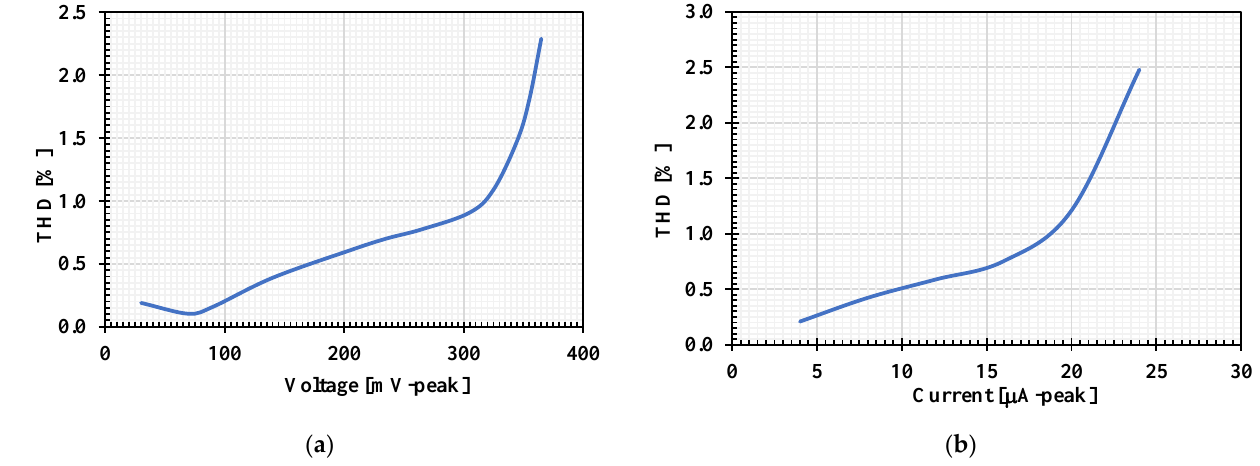
Figure 12. The simulated THD of the LP filters with different amplitude of input signal at 100 Hz: ( a ) VM filter; ( b ) CM filter. The proposed filter was investigated by applying two tones closely spaced in frequency into the input of the BP filter and the third-order distortion products (IMD3s) produced by the circuit nonlinearity were determined. In this case, the IMD3 of the VM and CM filters was investigated by applying the first tone with a sine wave frequency of 0.9 kHz and